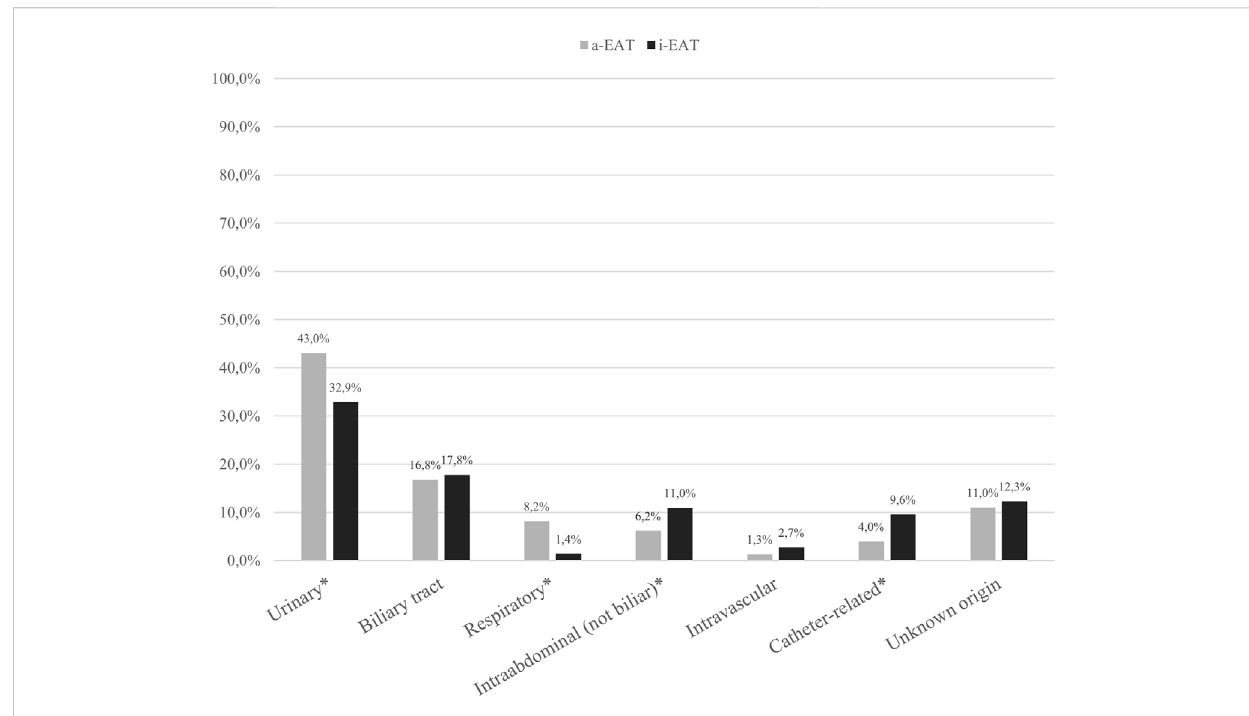
FIGURE 1 Empirical antimicrobial treatment appropriation according to infection